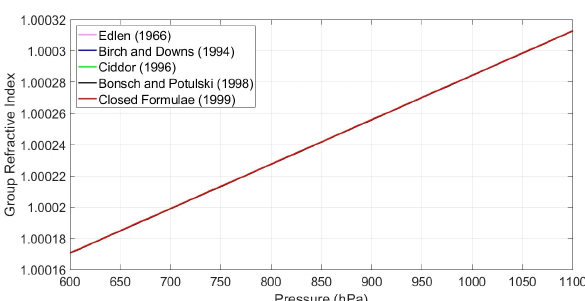
Figure 10. Effect of pressure on group refractive index of air calculated in EDM correction models